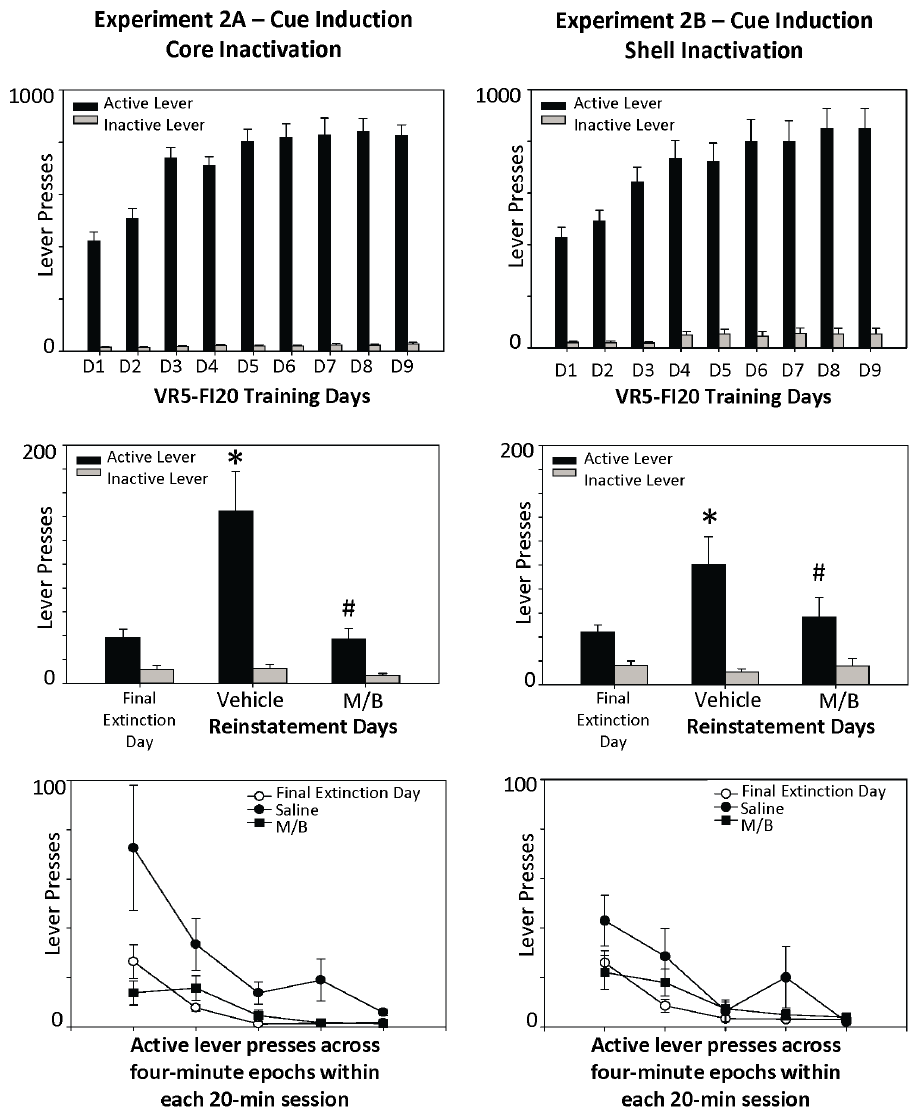
Figure 3. Effects of NAcc core and shell inactivation on cue-induced reinstatement. Top panels demonstrate that rats were showing robust lever-pressing on the VR-5, FI-20 schedule by the completion of training (top panels). The middle panels demonstrate a significant effect of NAcc inactivation on cue-induced reinstatement on the previously active lever, regardless of whether the muscimol/baclofen cocktail was injected into the core or the medial shell. There were no changes in pressing on the inactive lever across extinction and reinstatement test conditions. Bottom panels represent the pattern of lever pressing across the reinstatement period and suggest that drug treatment blocked reinstatement early in the session, which then extinguished across time during all test days. Statistical symbols are consistent with those used in Fig.